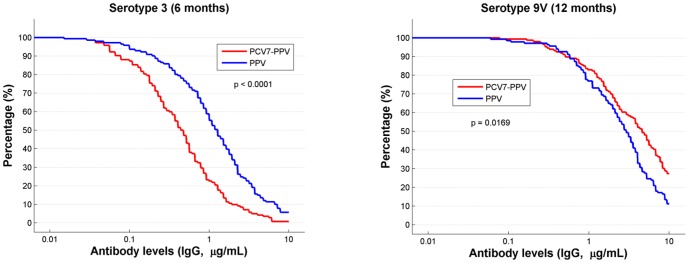
Reverse cumulative distribution (RCD) graphs for serotypes 3 at 6 months and serotype 9V at 12 months (based on ELISA IgG, µg/mL).